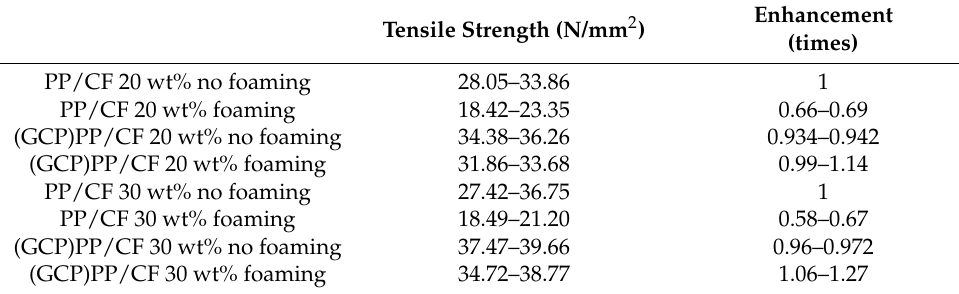
Table 5. Comparisons of TS molded under various processing